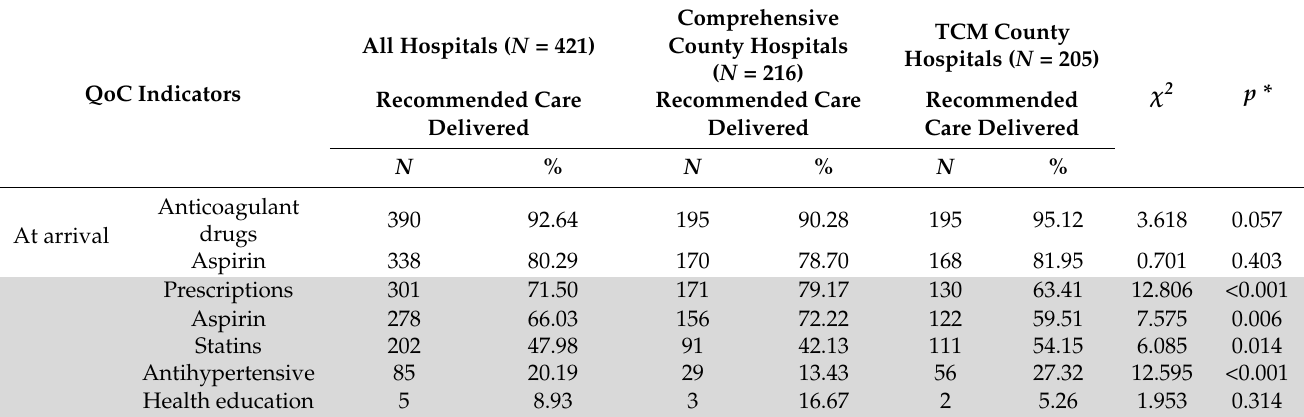
Table 3. Level of QoC for stroke in 2 kinds of county hospitals ( N = 421).